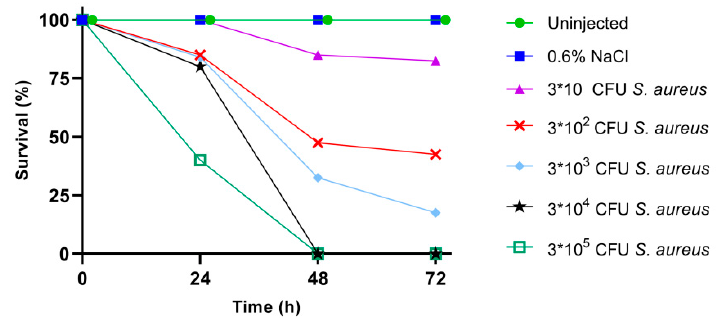
Figure 2. Survival rate of larvae infected with different concentrations of S. aureus (CFU, colony forming unit).